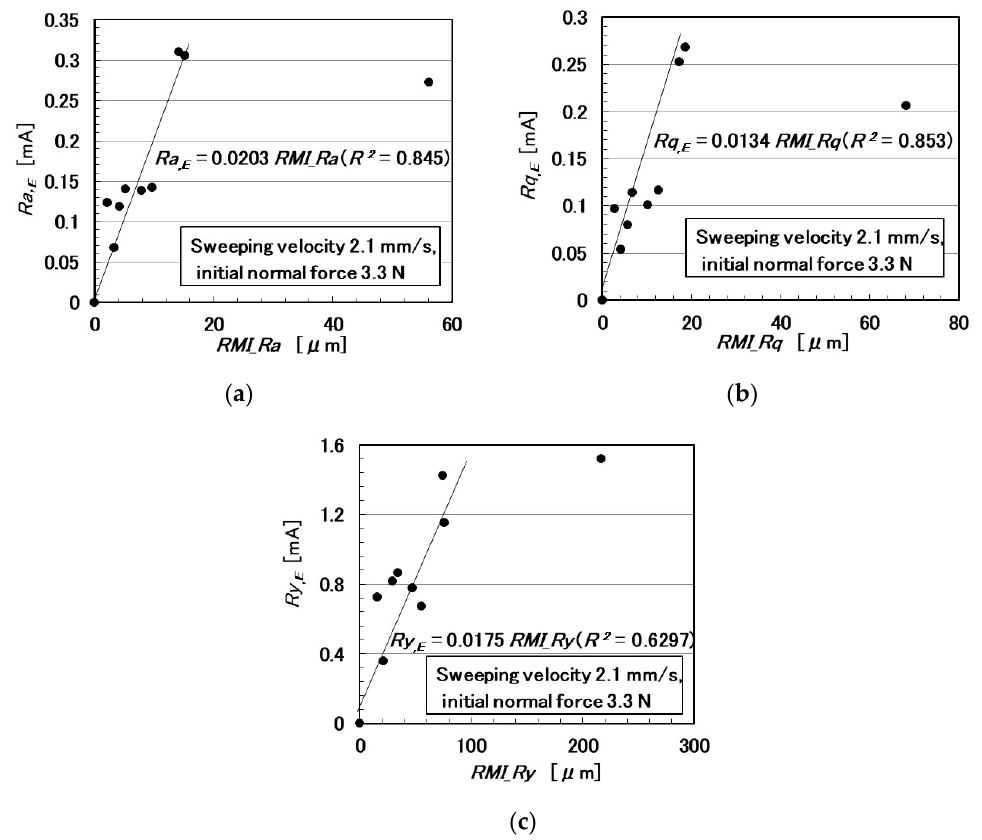
Figure 5. Relationship between electric current and surface roughness: ( a ) Ra .; ( b ) Rq .; and ( c ) Ry .